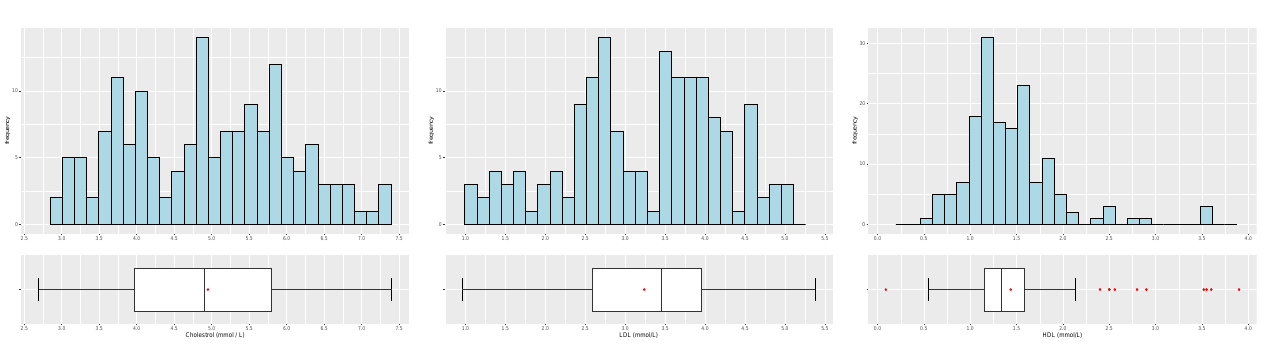
Figure 6. Distribution of the patients by systolic blood pressure ( left ), diastolic blood pressure ( center ) and F-glucose ( right ).